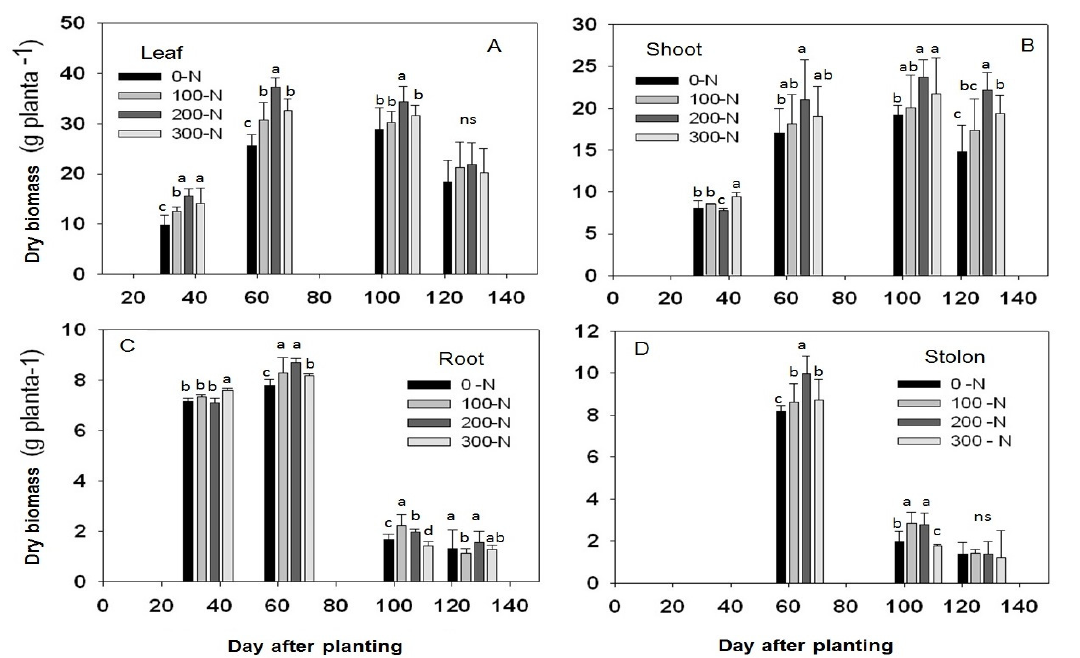
Figure 3. Pattern of dry weight accumulation of different organs during days after planting (DAP) for in the different treatments of nitrogen fertilization: 0, 100, 200 and 300 kg N ha -1 . The different letters indicate that there are significant differences between treatments per sampling period (p